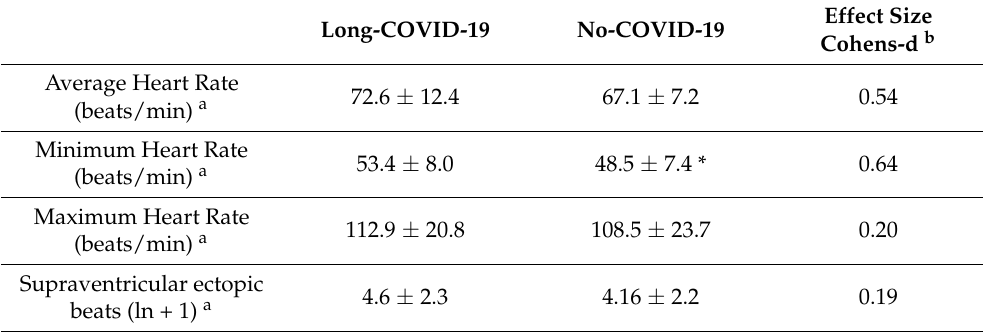
Table 3. Twenty-four-hour ECG monitoring in Long-COVID-19 and No-COVID-19